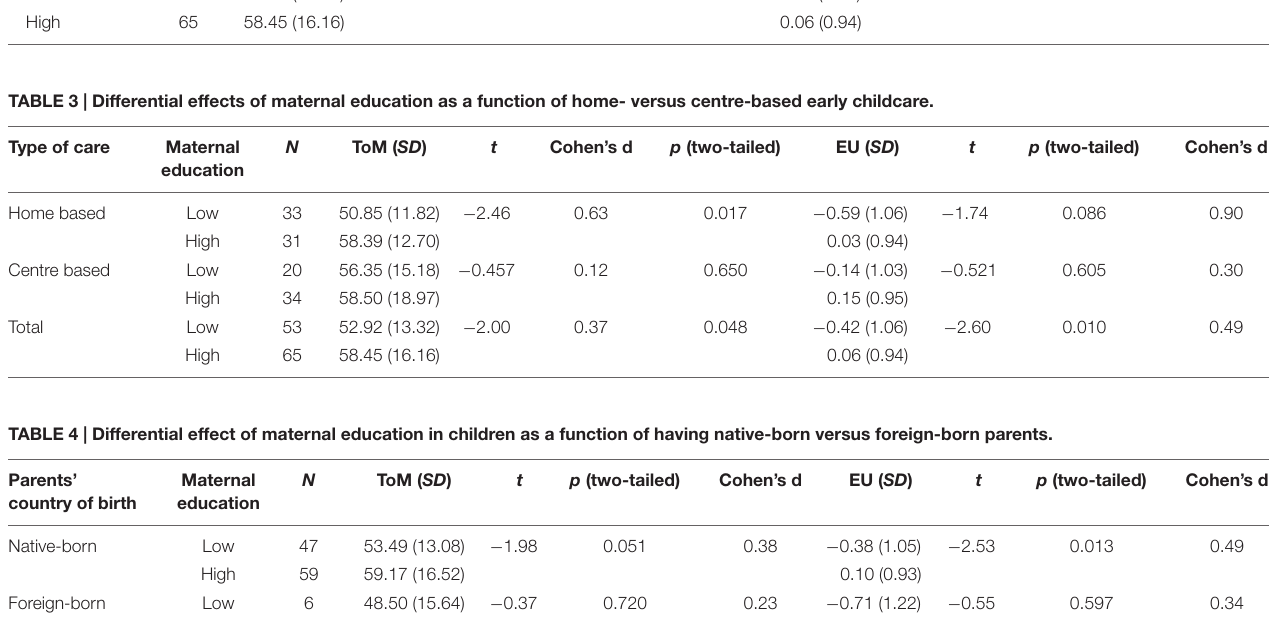
TABLE 3 | Differential effects of maternal education as a function of home- versus centre-based early childcare. Type of care